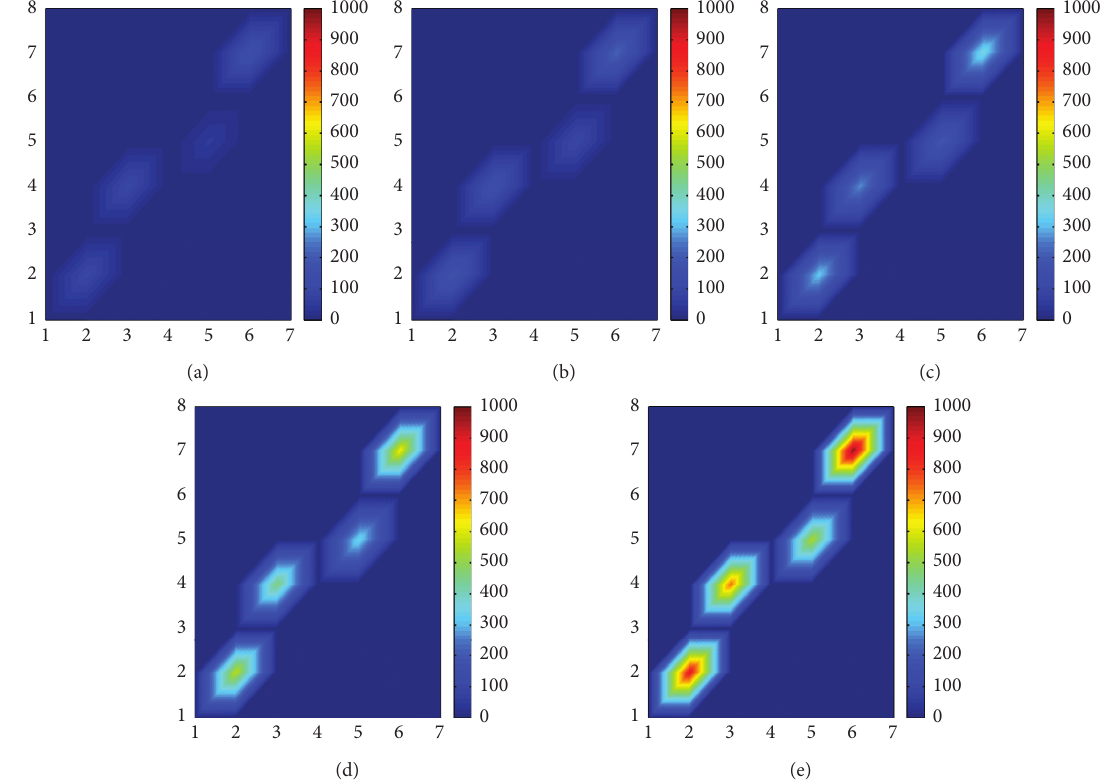
Figure 6: The biomass of top predator behavior within Ω without the control. (a) t � 0. (b) t � 50. (c) t � 100. (d) t � 150. (e) t �